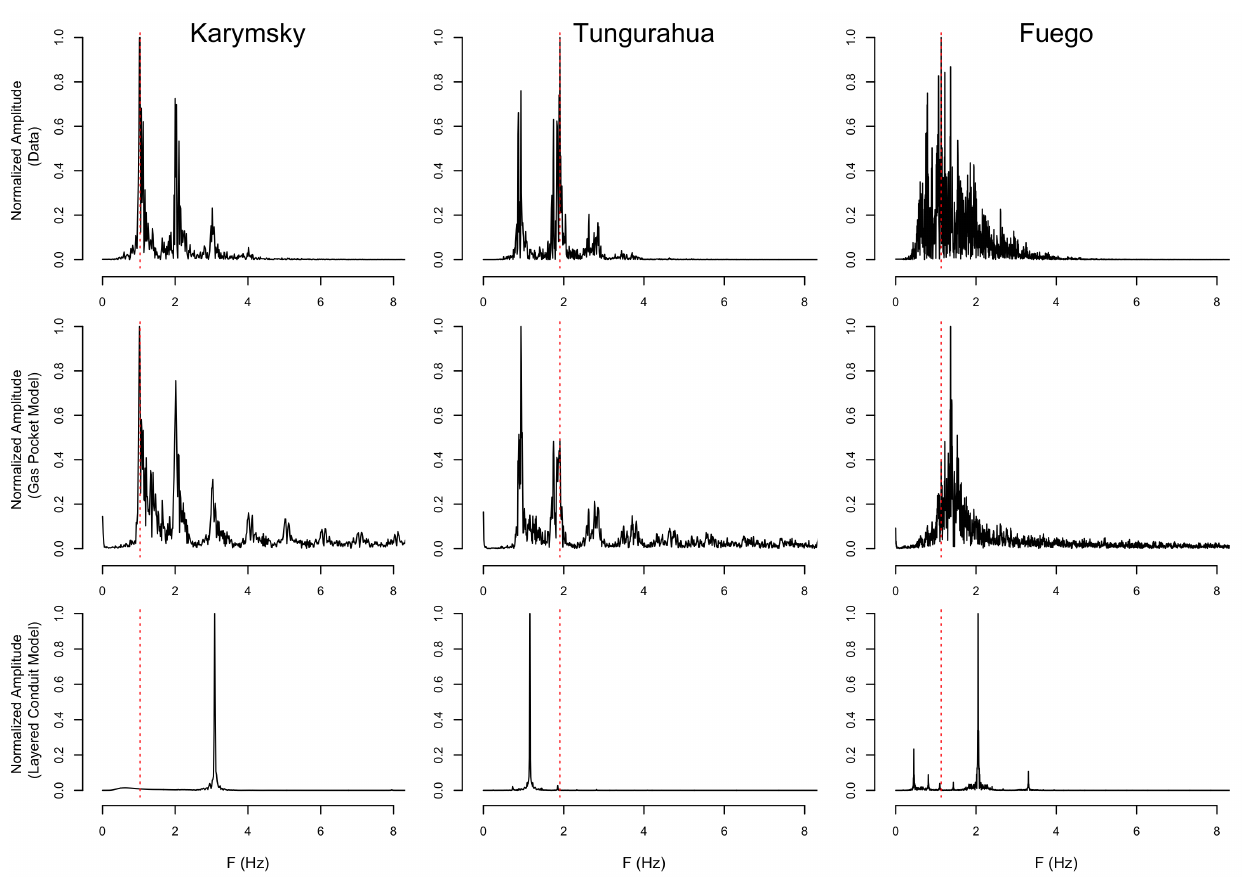
Figure 5: Normalized Fourier transform of chugging signals recorded at each volcano. The top row shows the spectra of a single recorded chugging sequence. The middle row shows the results of the plugged gas pocket model [Girona et al. 2019] and the bottom row shows the spectra calculated by the resonating layered conduit model [Garcés 1997]. Columns are organized and labeled by volcano and red dashed lines indicate the dominant frequency of the recorded